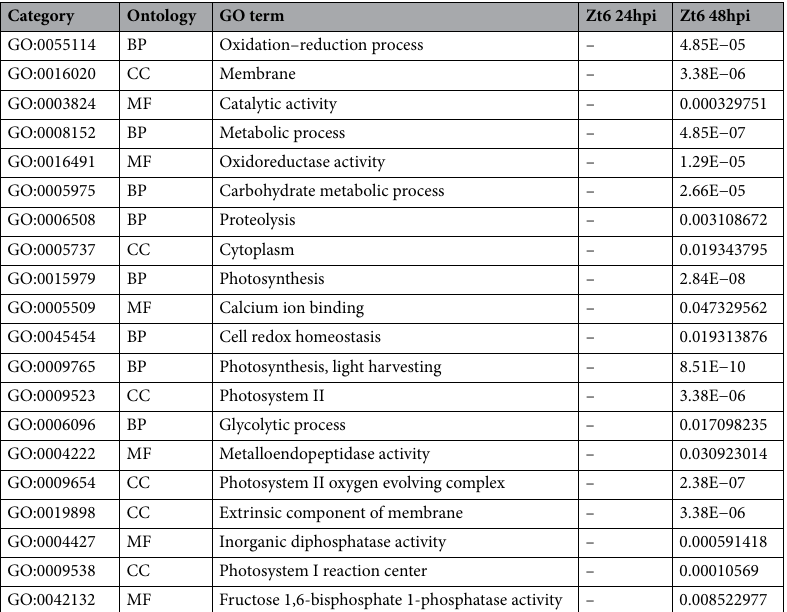
Table 3. Top 20 GO terms enriched among Zt6 treatment in downregulated DEGs and their BH-FDR adjusted P values.